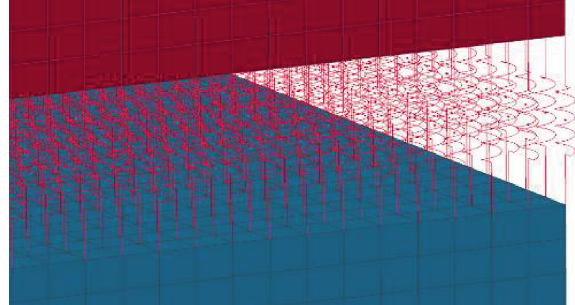
Figure 4: Schematic diagram of layout for the COMBI165